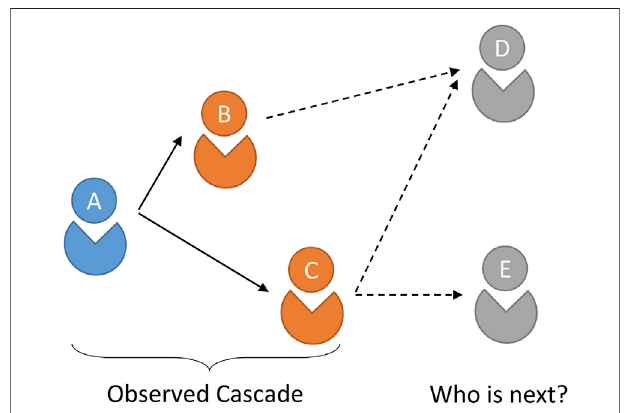
FIGURE1| Atoyexampleofcascadeprediction,whichcontainsseveral users who participated in information diffusion. A → B → C is a observed cascade in social network, we will predict who is the next infected user, D or E?